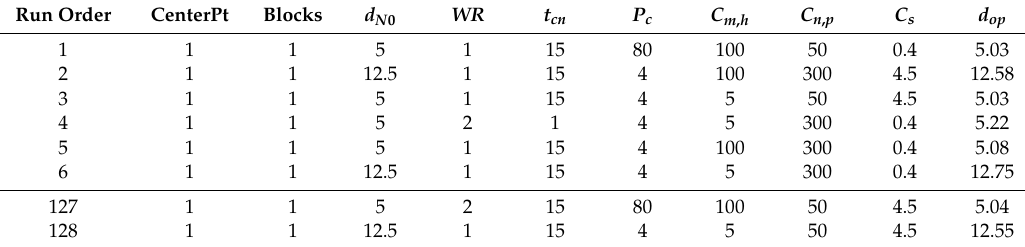
Table 2. Experimental plans and output response.